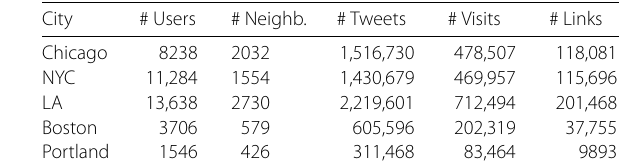
Table 1 Network statistics for indicator group